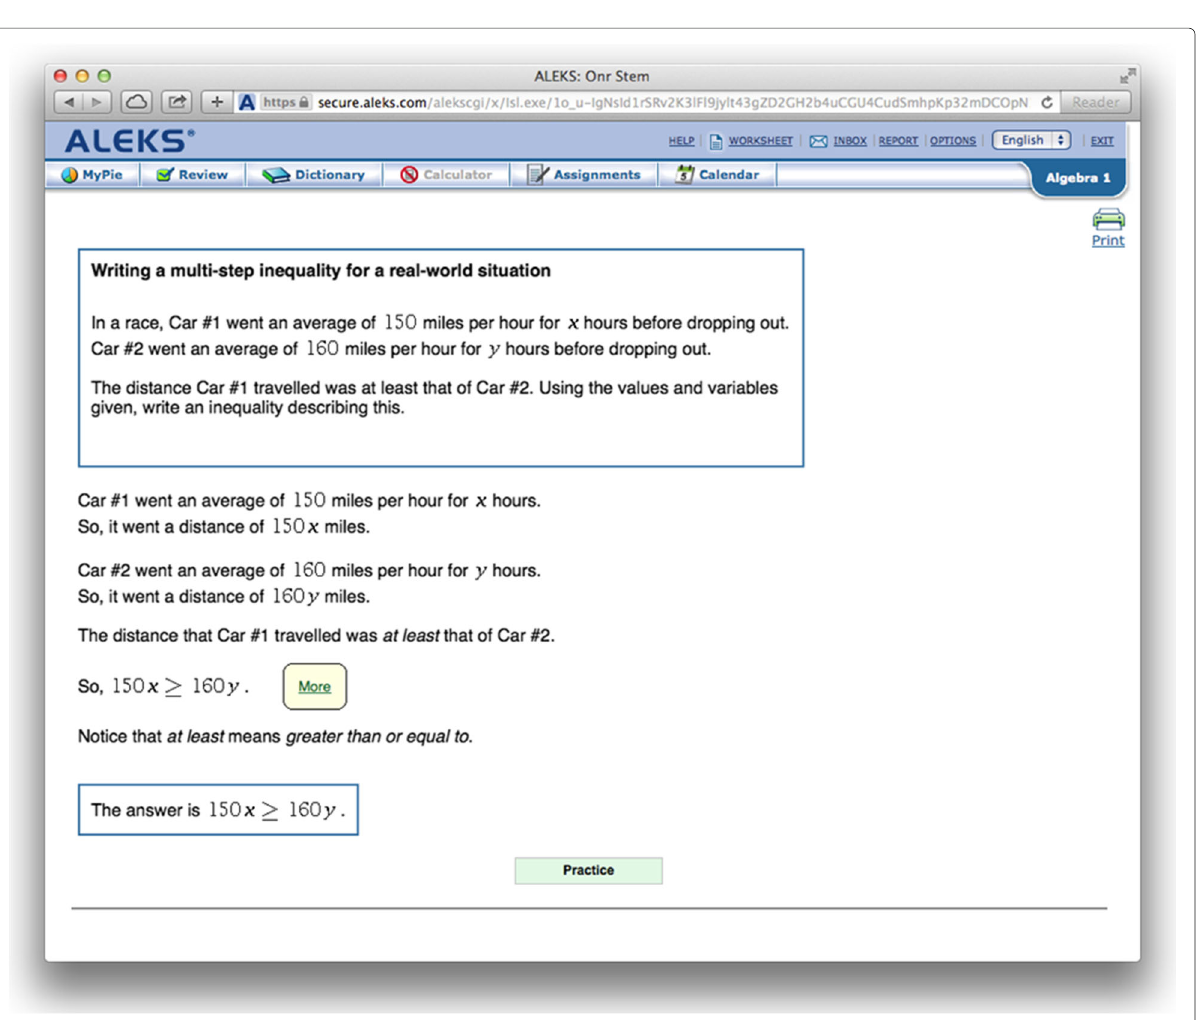
Fig. 3 ALEKS explanation: a worked example presented by